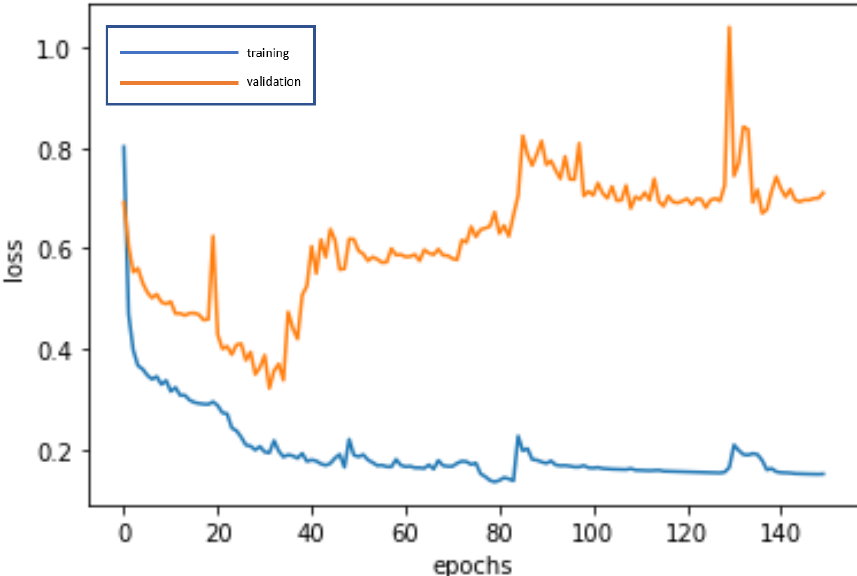
Figure 10. Graph of loss function of the DNN modeling.